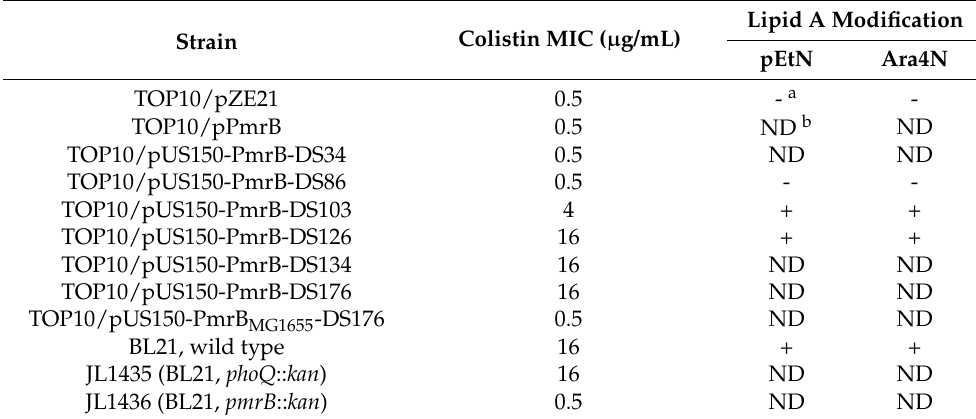
Table 4. Colistin MIC and lipid A modification of the E. coli TOP10 constructs carrying pmrB BL21 with different lengths of 3 (cid:48) -downstream